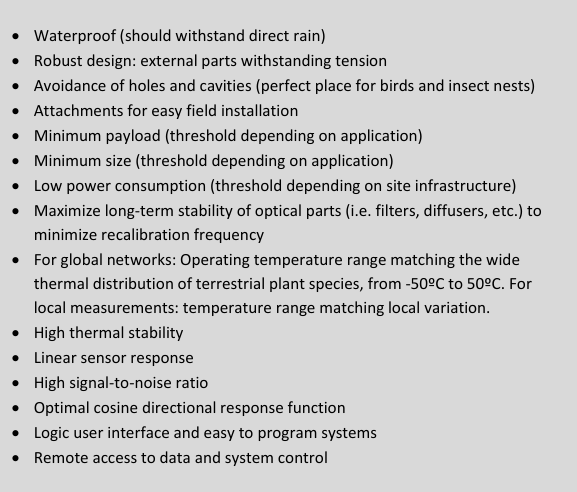
Box 1. General requirements for in situ long-term optical sensors.